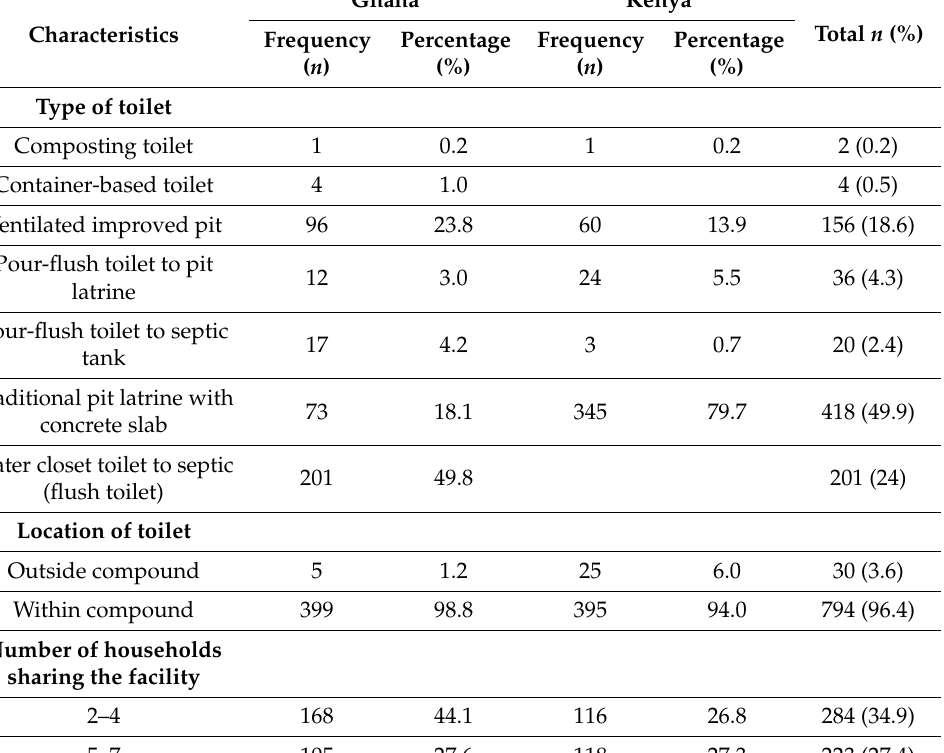
Table 3. Characteristics and management of shared toilet facilities in Ghana and Kenya.